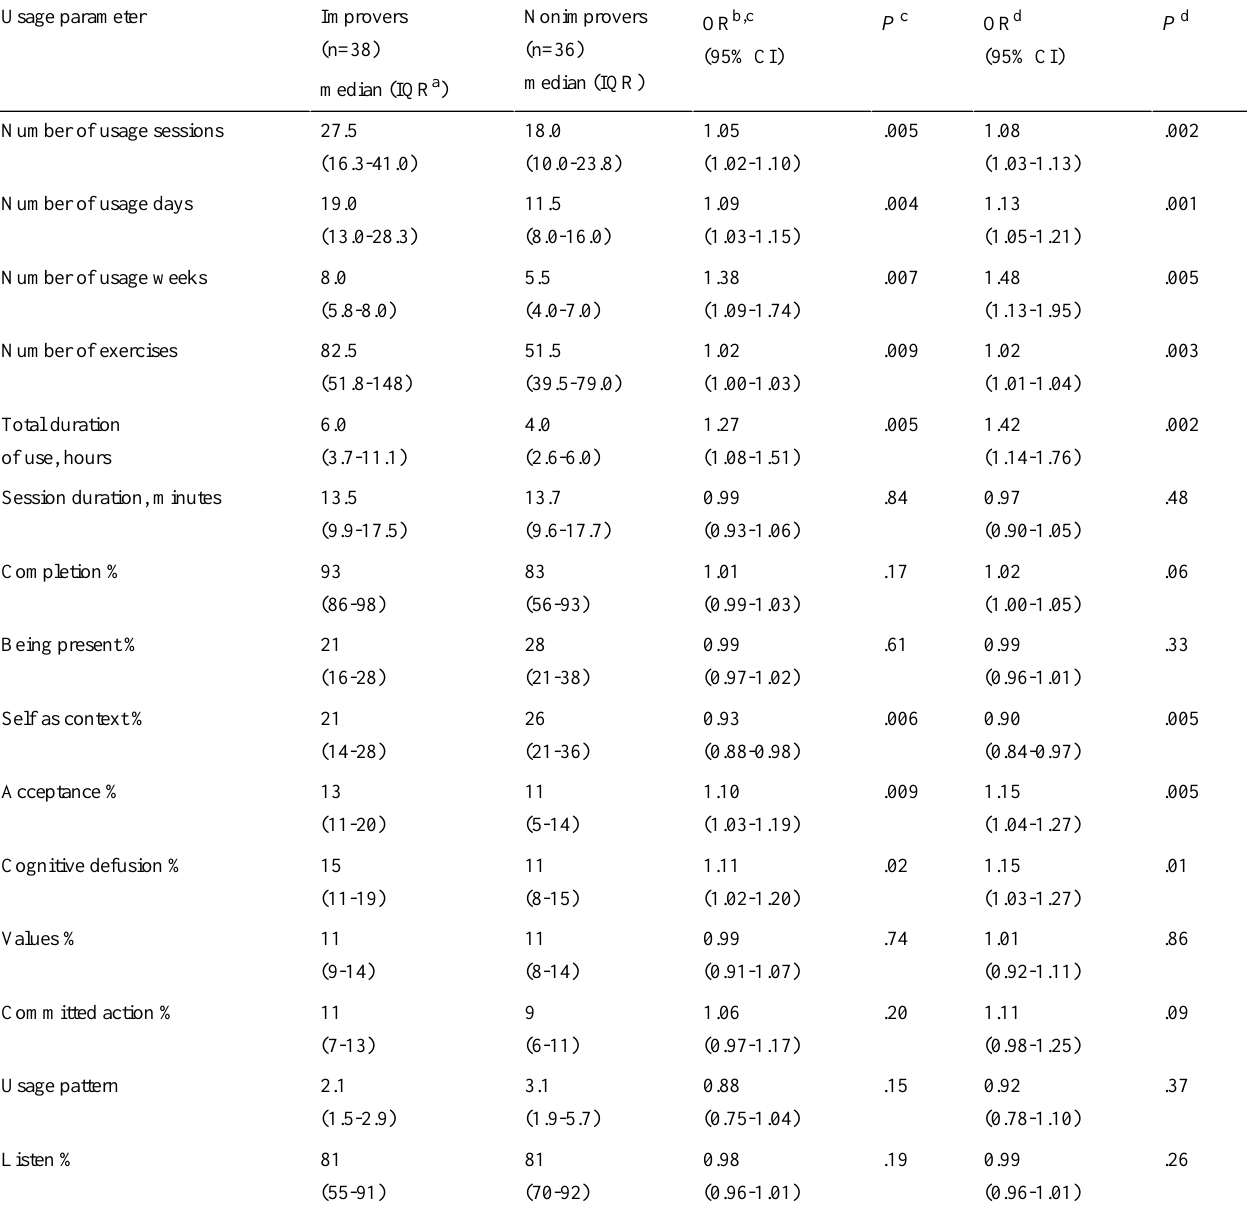
Table 4. Logistic regression analysis; associations between usage parameters and improvement in psychological